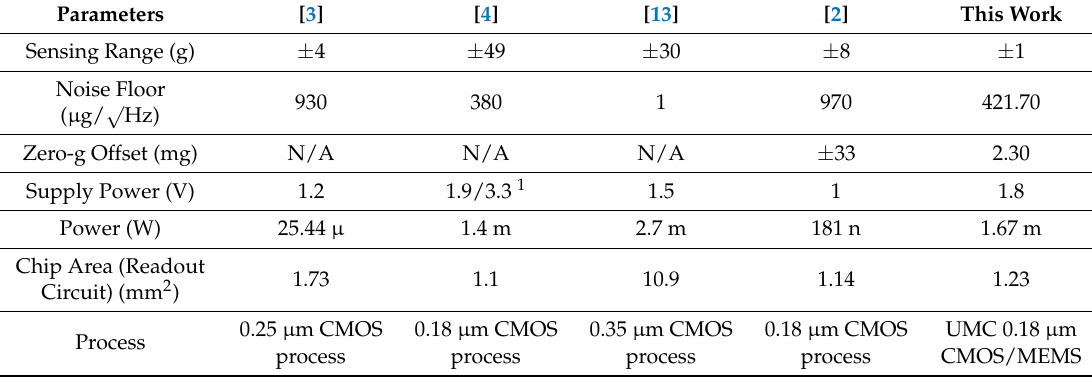
Table 3. Comparison of the proposed readout scheme to the